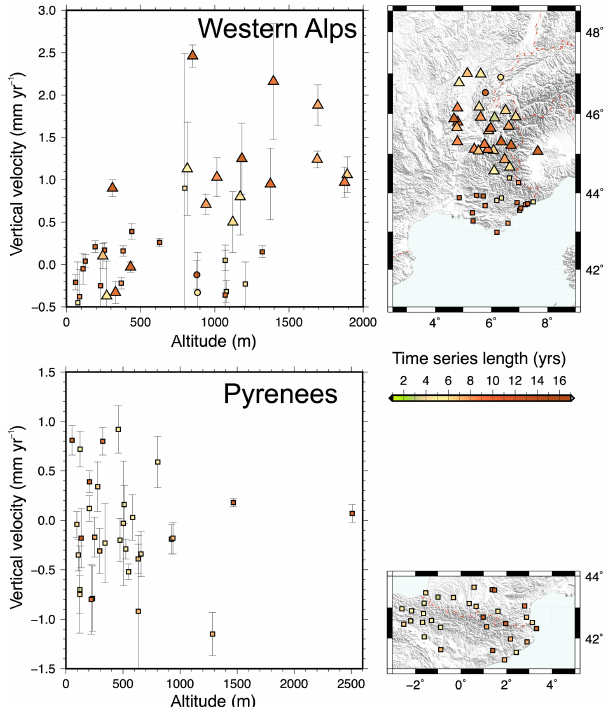
Figure 10. Vertical velocities, color-coded based on the time-series length, vs. site elevations for stations located in the Western Alps and the